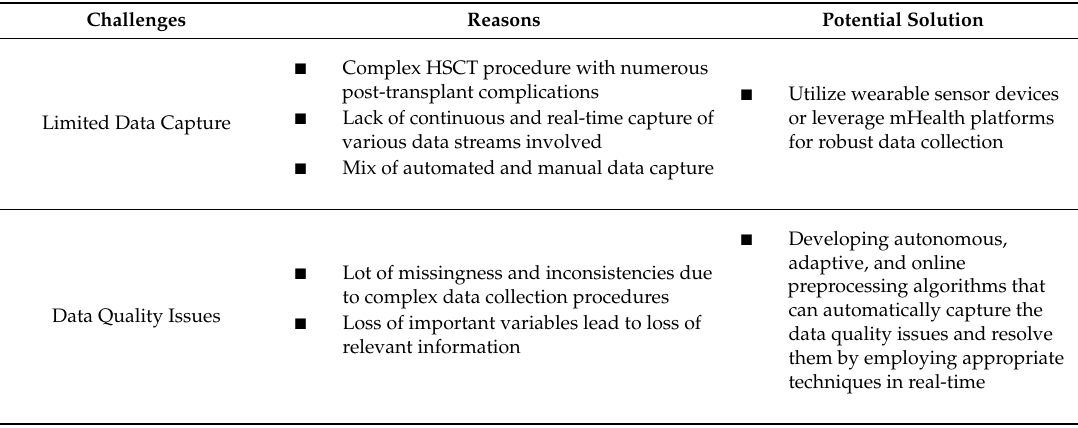
Table 3. Summary of challenges in applying ML techniques in